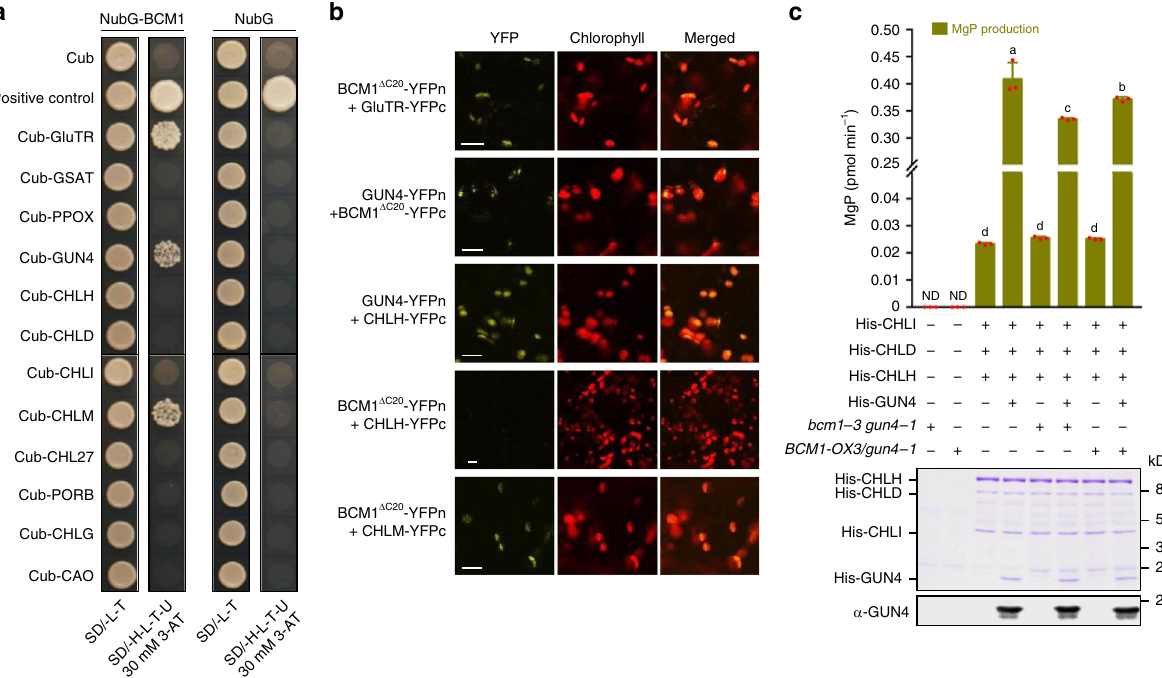
Fig. 4 BCM1 interacts with GUN4 and stimulates MgCh activity via GUN4. a Y2H analyses of interactions between BCM1 and CBEs. The transformed yeast strains were analyzed on selective medium lacking Leu and Trp (SD/-L-T) or His, Leu, Trp and Ura (SD/-H-L-T-U) in the presence of 30 mM 3- amino-1,2,4-triazole (3-AT). The combination of NubG-GluTR and Cub-GBP was used as the positive control. The NubG was used as the negative control for NubG-BCM1. b BiFC assays for interactions between BCM1 and CBEs. Co-expression of BCM1 Δ C20 -YFPn with CHLH-YFPc served as the negative control, and the combination of GUN4-YFPn with CHLH-YFPc served as the positive control. Scale bars, 10 μ m. c In vitro MgCh assay. Production of MgP in the assay was measured by HPLC and quanti fi ed relative to incubation time. Recombinant proteins used in the assay were stained with Coomassie Brilliant Blue (middle panel) and probed with GUN4 antibody (bottom panel), respectively. ND, not detected. Error bars represent SD of three biological replicates. Letters above histograms indicate signi fi cant differences as determined by Tukey ’ s HSD method ( P <